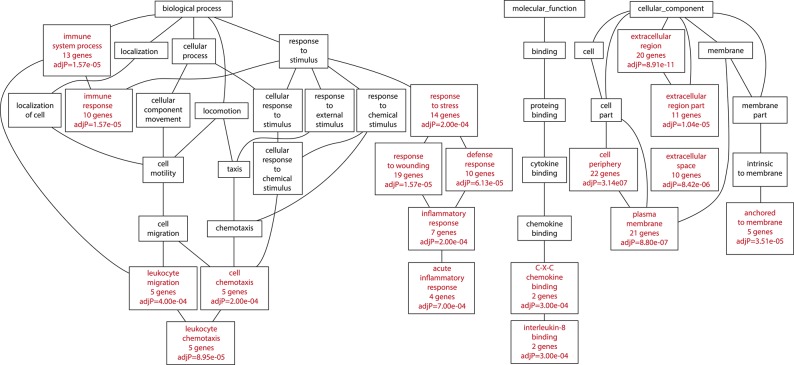
Biological processes impacted by up-regulated genes in animals infected with strain 46 compared with animals infected with strain 46P at day 21 postinfection.